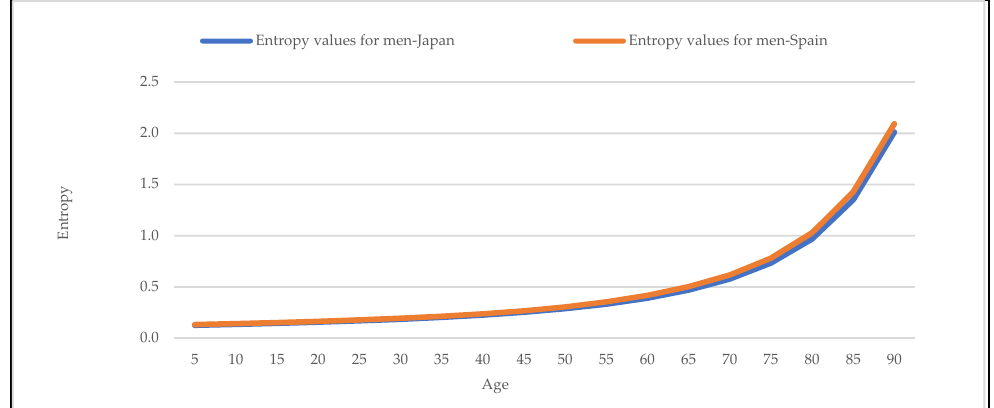
Figure 4. Japan vs. Spain entropy measurements for the male population according to the age of the individual. Source: authors.